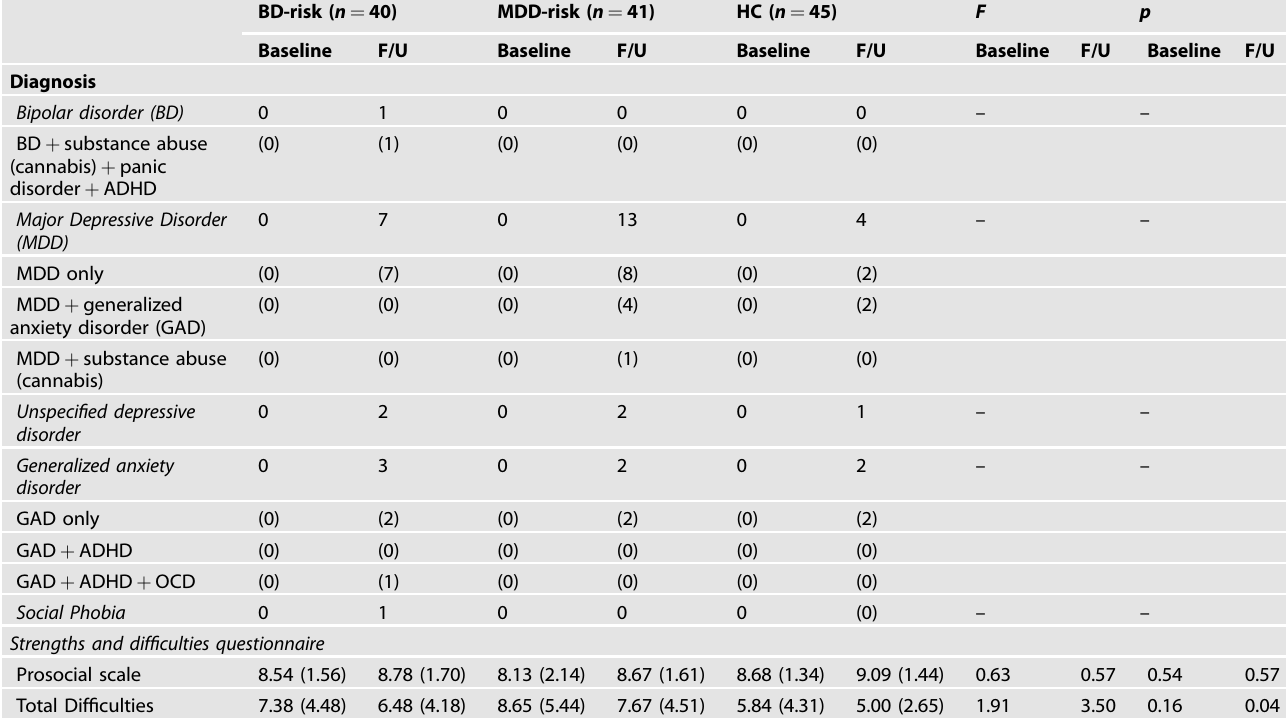
Table 2. Participant diagnostic and behavioral characteristics at baseline and